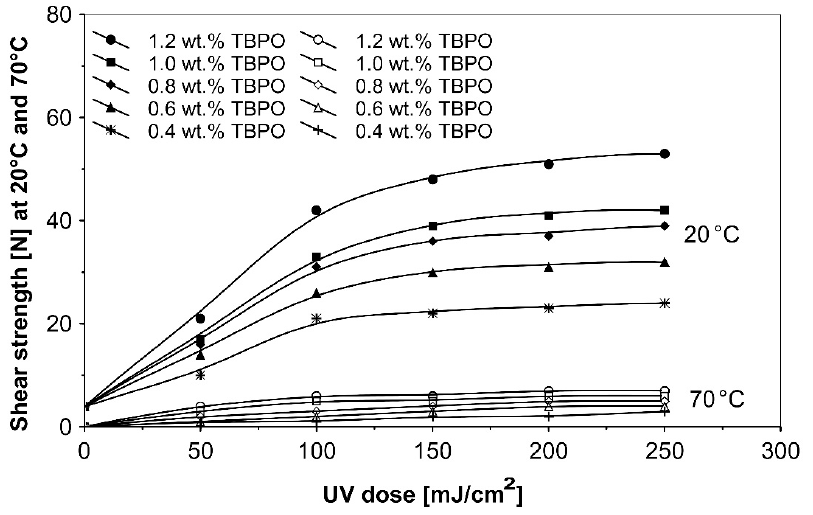
Figure 10. Shear strength versus UV dose for the use of tris-benzophenyloxy phosphineoxide (TBPO).